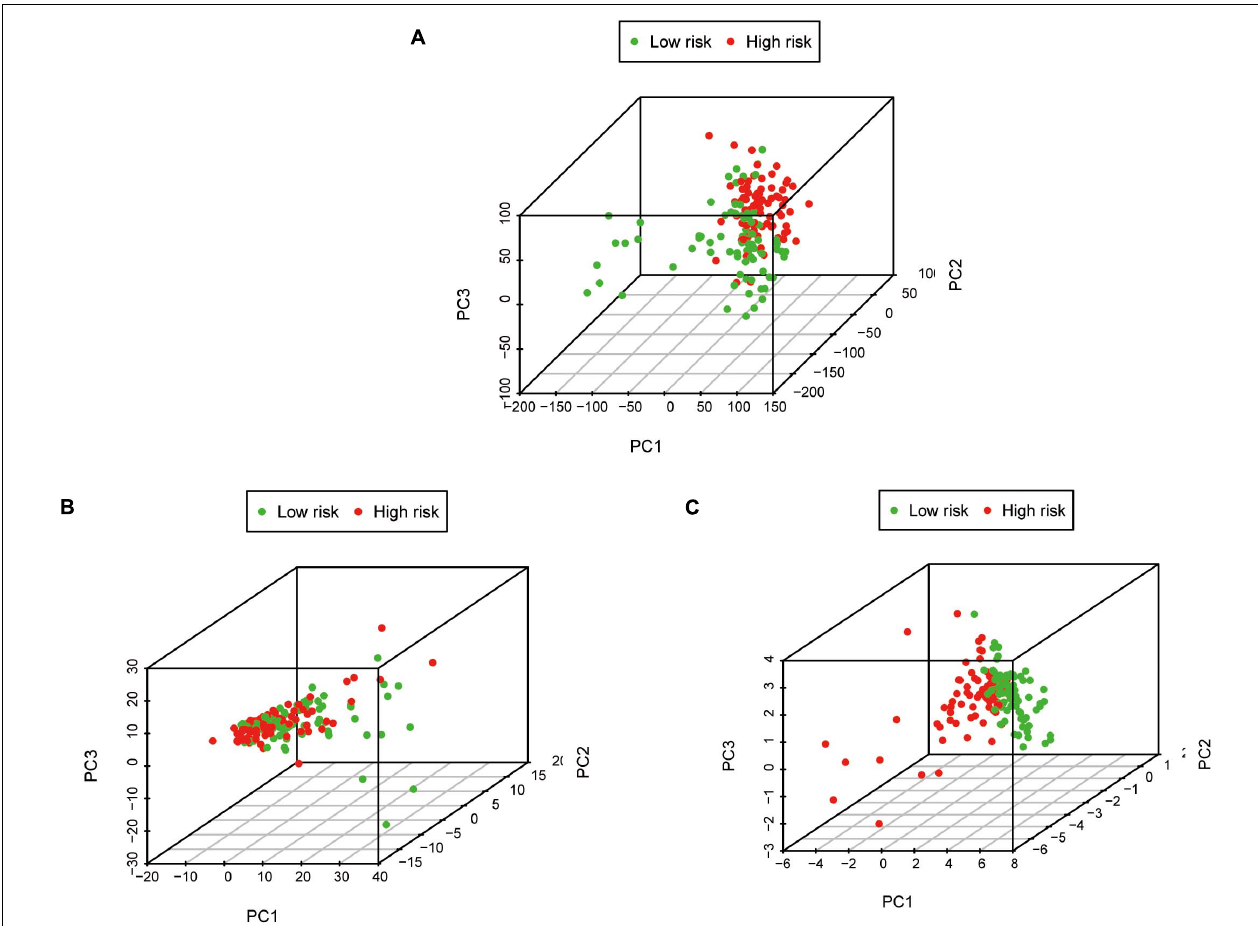
FIGURE 6 | Principal component analysis between low-risk and high-risk groups based on different classification methods. (A) All genes, (B) Immune genes, and (C) Risk